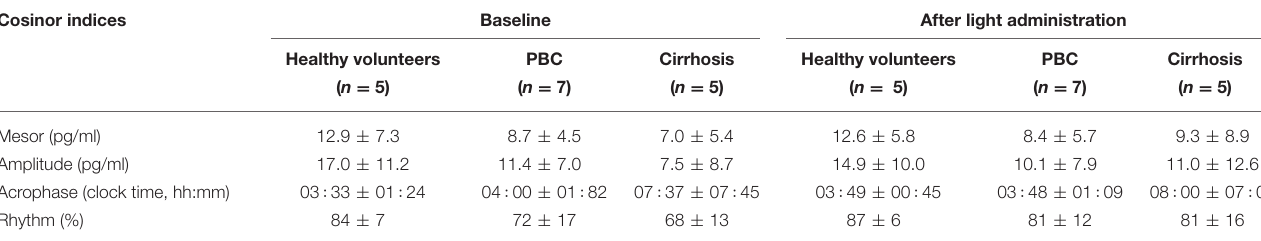
TABLE 3 | 6-sulfatoxymelatonin (aMT6s) cosinor indices (mean ± SD), by group and in relation to treatment. Cosinor indices Baseline